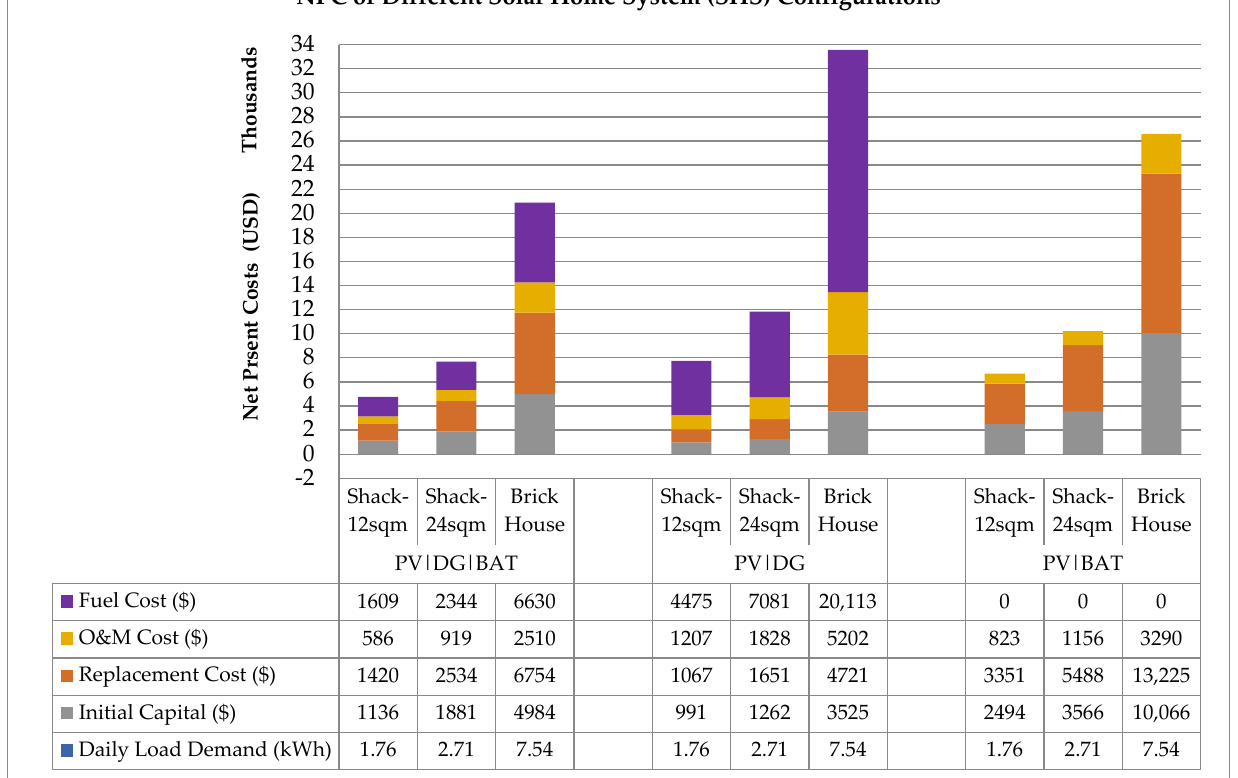
Figure 12. Comparing costs of different SHS system configurations.